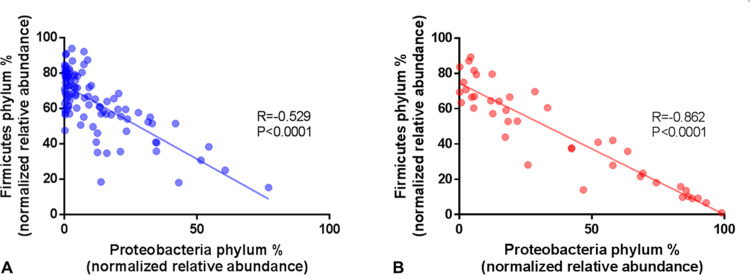
Correlation of the phyla Proteobacteria and Firmicutes in DA from (A) non-SIBO (N = 98) and (B) SIBO (N = 42) subjects.